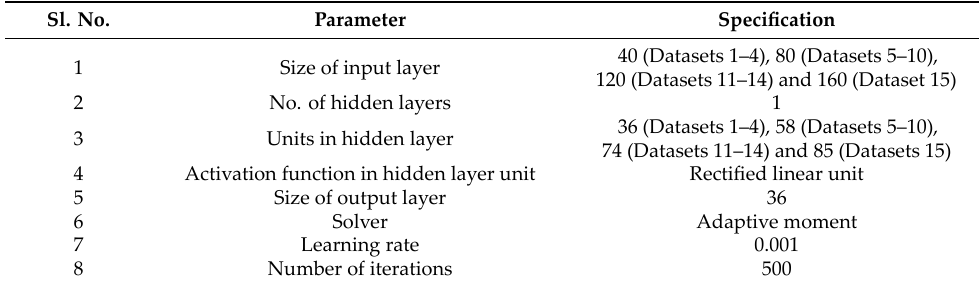
Table 4. Specifications of an MLP classifier as used in the proposed work. Sl. No.